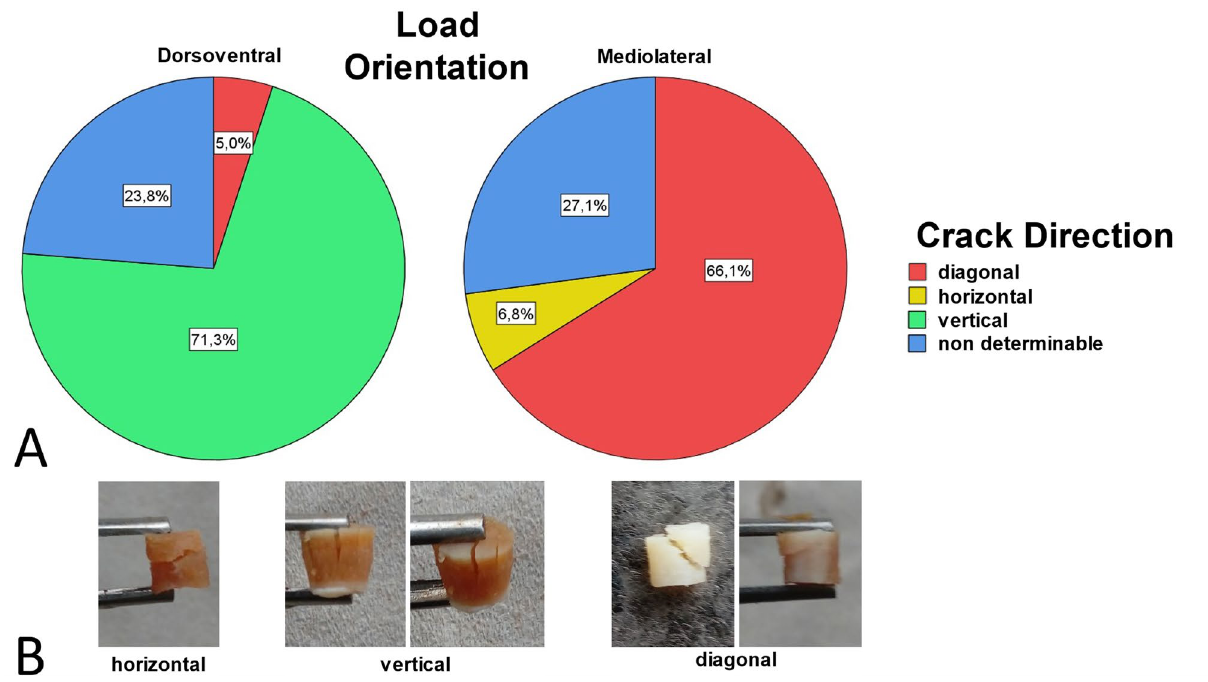
Figure 6. Direction of the crack at failure of the samples for the unconfined compression test. ( A ) The graph shows the percentage of samples broken diagonally, horizontally or vertically for each load direction, as well as those samples for which the crack direction could not be determined visually. ( B ) Examples of fractured samples.